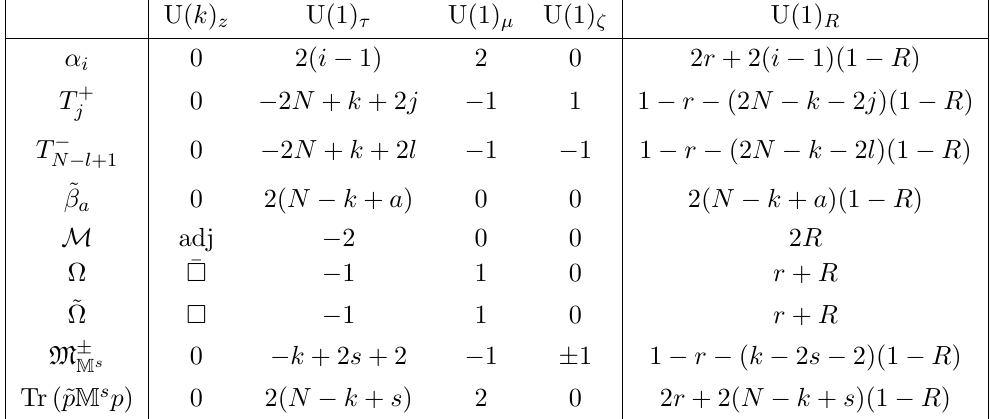
Table 5 . Chiral ring generators of Theory